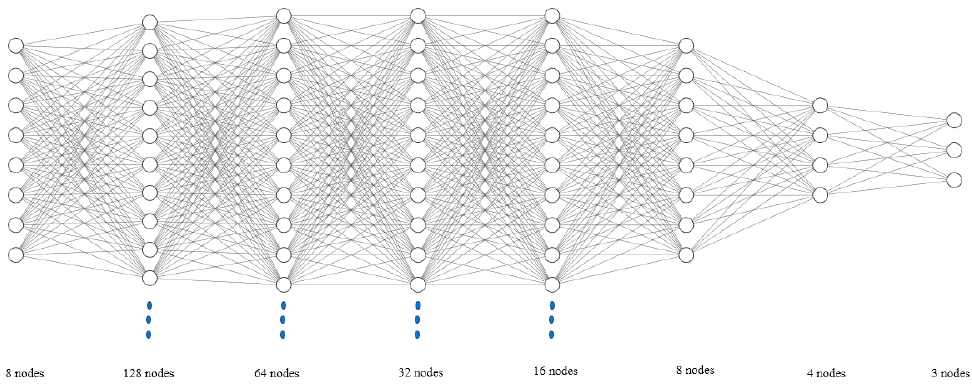
Figure 2. Schematic of ANN Figure 2. schematic of ANN architecture